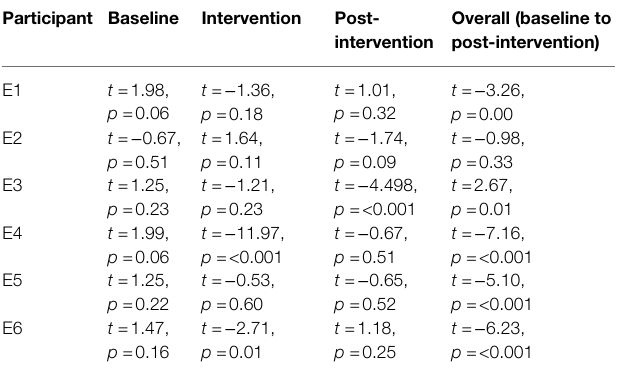
TABLE 5 | Time-series analysis results for participants E1–E5 using Destressify . Participant Baseline Intervention Post-